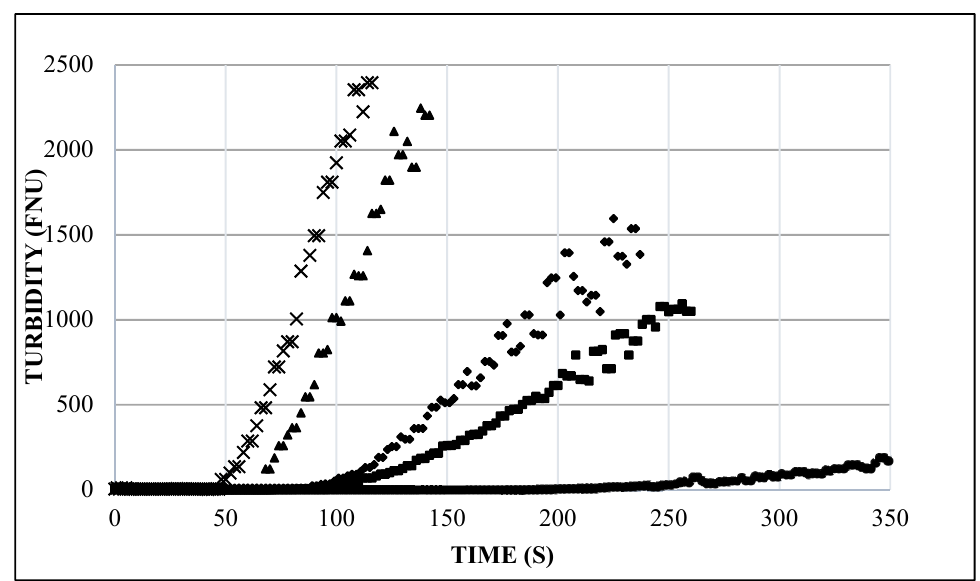
Figure 1. Influence of concentration on induction time: • 0.15 M; ■ 0.20 M; ♦ 0.25 M; ▲ 0.30 M; × 0.35 M.